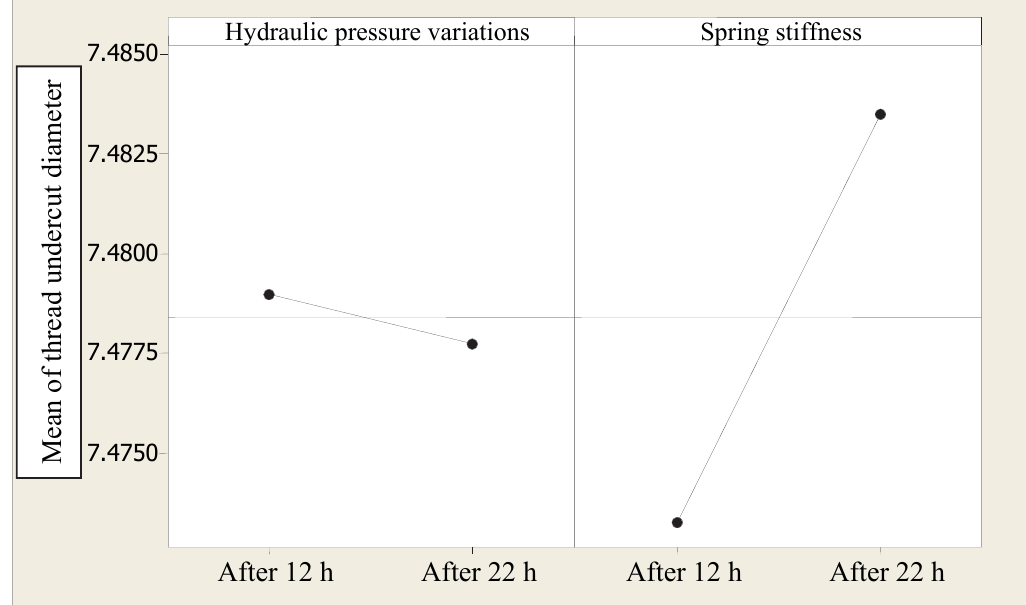
Fig. 7. Main Effects Plot for Thread Undercut Diameter Interaction Plot for thread undercut